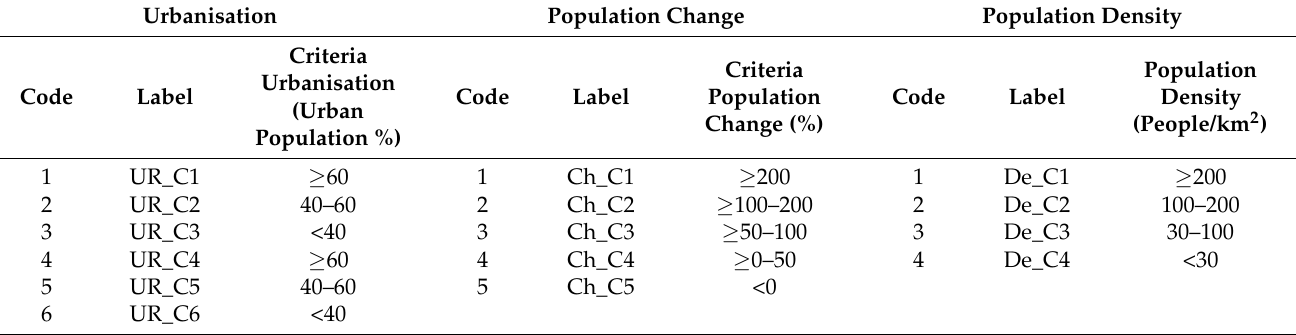
Table 5. Codes and relative groupings of ranges used to generate trajectories.